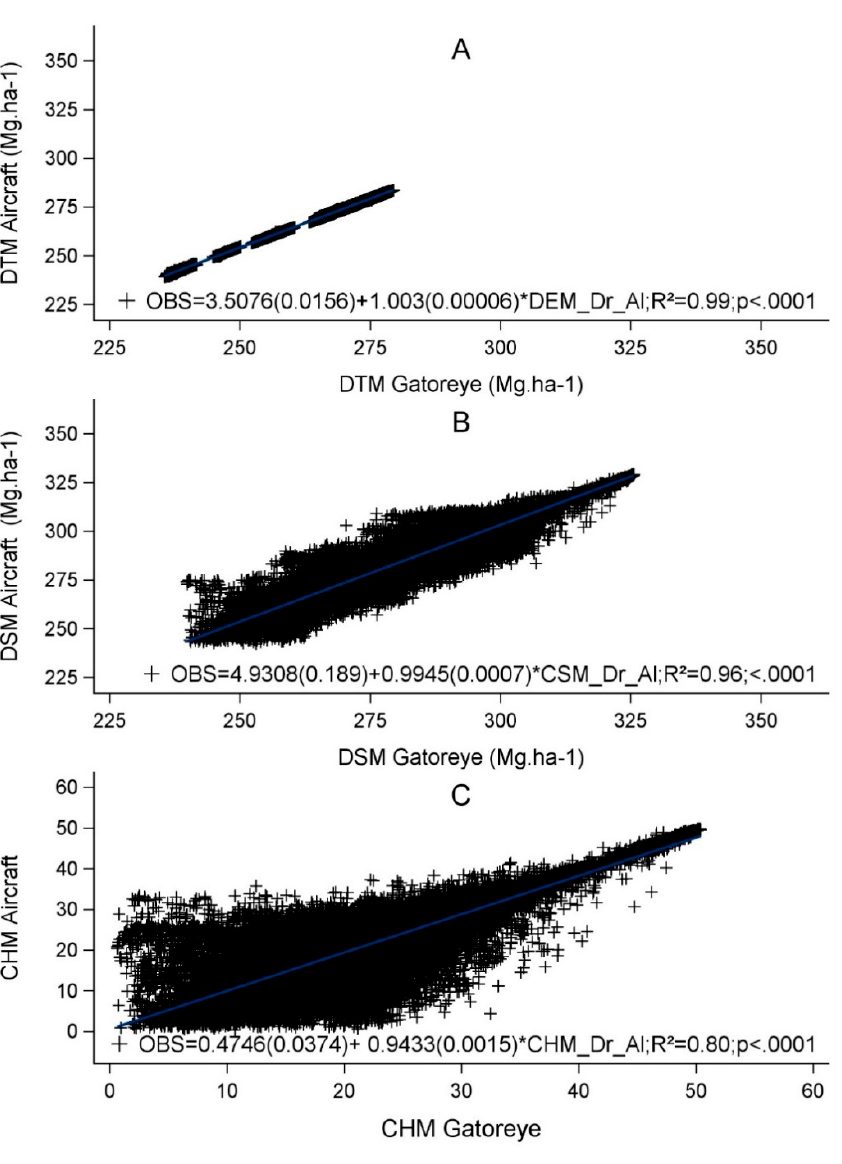
Figure 5. Comparison of the digital terrain model (( A )—DTM), digital surface model (( B )—DSM), and digital height model (( C )—DHM / canopy height model (CHM)) produced by aircraft and GatorEye systems. Numbers in parentheses are the standard errors for each coefficient.